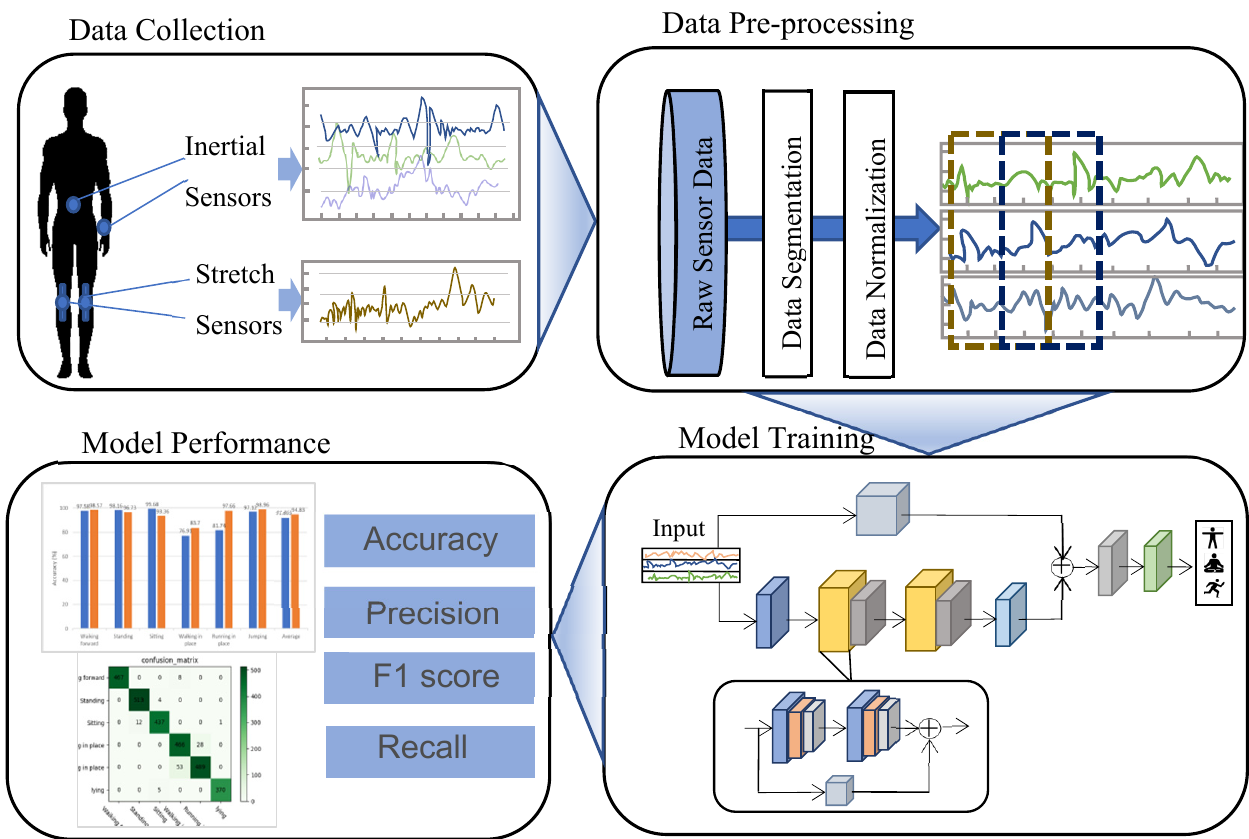
Figure 1. A deep learning-based human activity recognition framework using wearable sensors.